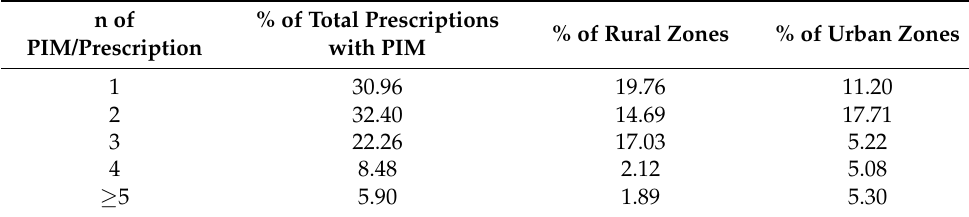
Table 5. Percent of medical prescriptions with potentially inappropriate medication (PIM).